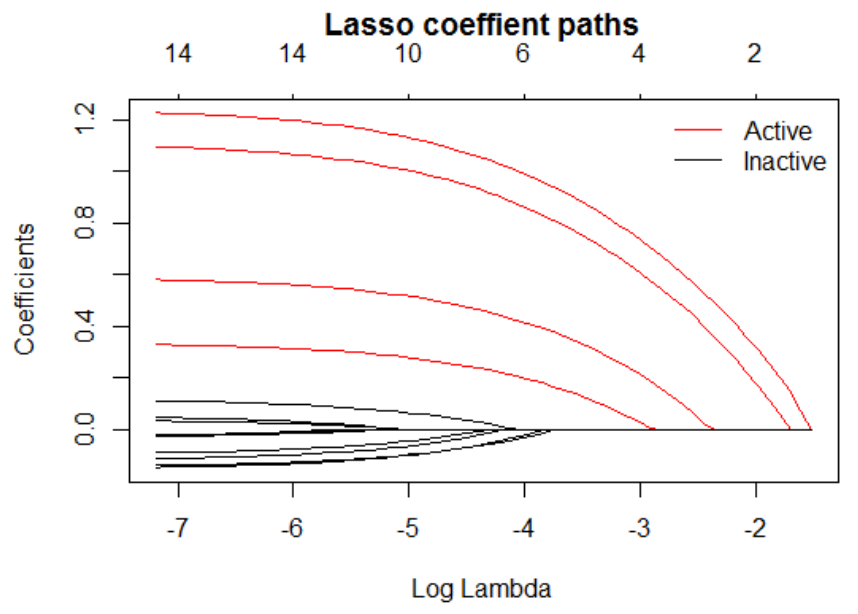
Figure 3. A lasso coefficient solution path.